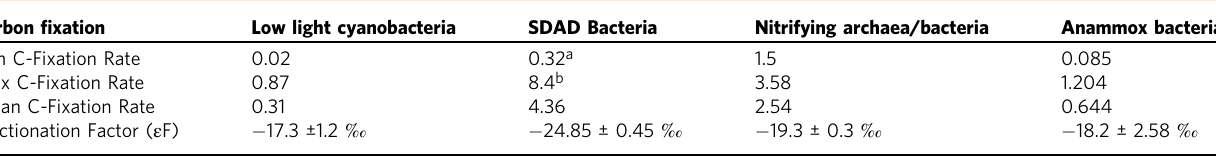
Isotope mass balance model includes average rates for each metabolism, except sulfur-driven autotrophic denitri fi cation (SDAD) a Minimum carbon fi xation rate applied for SDAD bacteria under Low SDAD scenario b Maximum carbon fi xation rate applied for SDAD bacteria under High SDAD